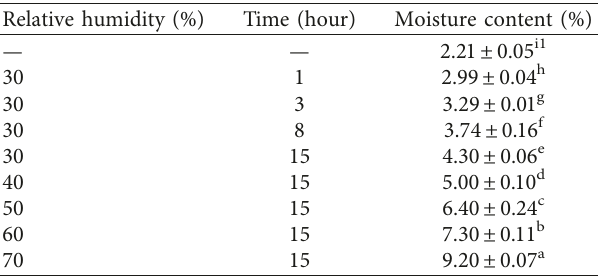
Table 1: Potato chip treatment for various moisture containing conditions and its moisture content